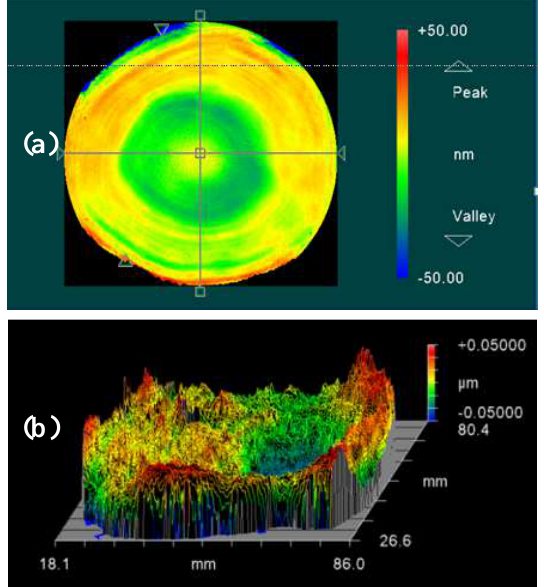
Fig. 8. Reflected wavefront introduced by the grating fabrication process (excluding substrate deformation) for e-beam grating (a) and for NIL grating